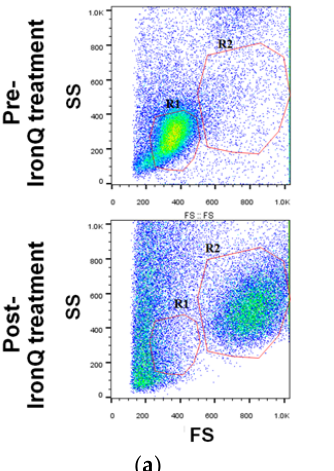
Figure 1. Proliferation and characteristics of the peripheral blood mononuclear cells (PBMCs) treated with the iron-quer- cetin complex (IronQ). ( a ) Representative phase-contrast images of the morphological states of PBMCs on day 10 of the culturing process. ( b ) PBMCs were cultured in the presence of 125 µg/mL of the IronQ complex. Morphological observa- tion at different time points revealed that IronQ increased the number of adherent cells by almost 90% confluence on day 14. ( c ) PBMCs were cultured in the presence of 125 µg/mL of the IronQ complex. Colony-forming unit-Hill (CFU-Hill) or early outgrowth endothelial progenitor cells (EPCs) were observed after 7 days of culturing. The yellow box areas in the upper images (×40) were magnified in the lower images (×100). Scale bar = 100 µm. ( d ) A proliferation assay over 10 days